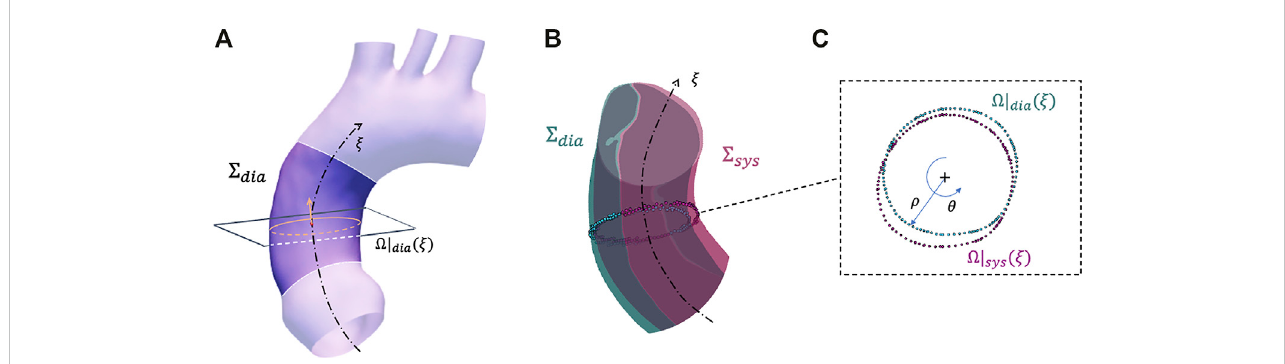
FIGURE 2 Summary of the strain estimation algorithm: example of a plane and closed contour de fi nition on con fi guration Σ dia (A) , corresponding closed contour de fi nition on con fi guration Σ sys (B) with closeup on plane with polar coordinates (C)